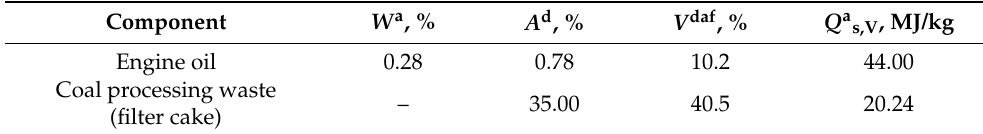
Table 1. Characteristics of components in composite